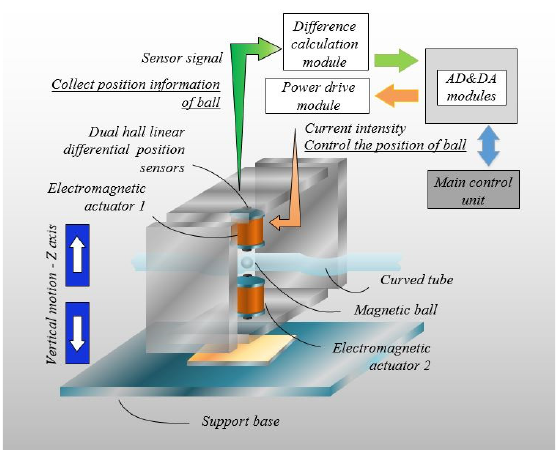
Figure 7. Position control process of the permanent magnet ball.